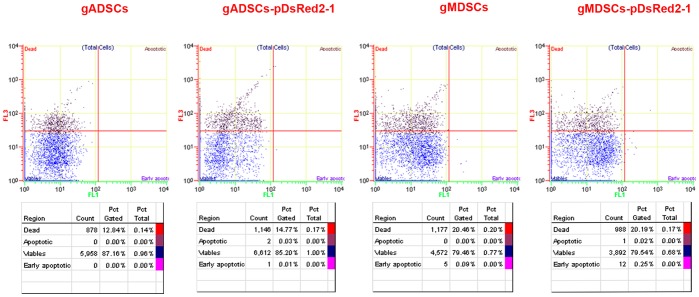
Apoptosis of gADSCs, gADSCs–pDsRed2-1, gMDSCs and gMDSCs–pDsRed2-1.The percentages of apoptotic and early apoptotic cells were 0.00% and 0.00%, and 0.00% and 0.09%, respectively, in 50th generation gADSCs and gMDSCs. The percentages of apoptotic and early apoptotic cells were 0.03% and 0.01%, and 0.02% and 0.25%, respectively, in 10th generation gADSCs–pDsRed2-1 and gMDSCs–pDsRed2-1. gADSCs, goat adipose-derived mesenchymal stem cells; gMDSCs, goat muscle-derived satellite cells.